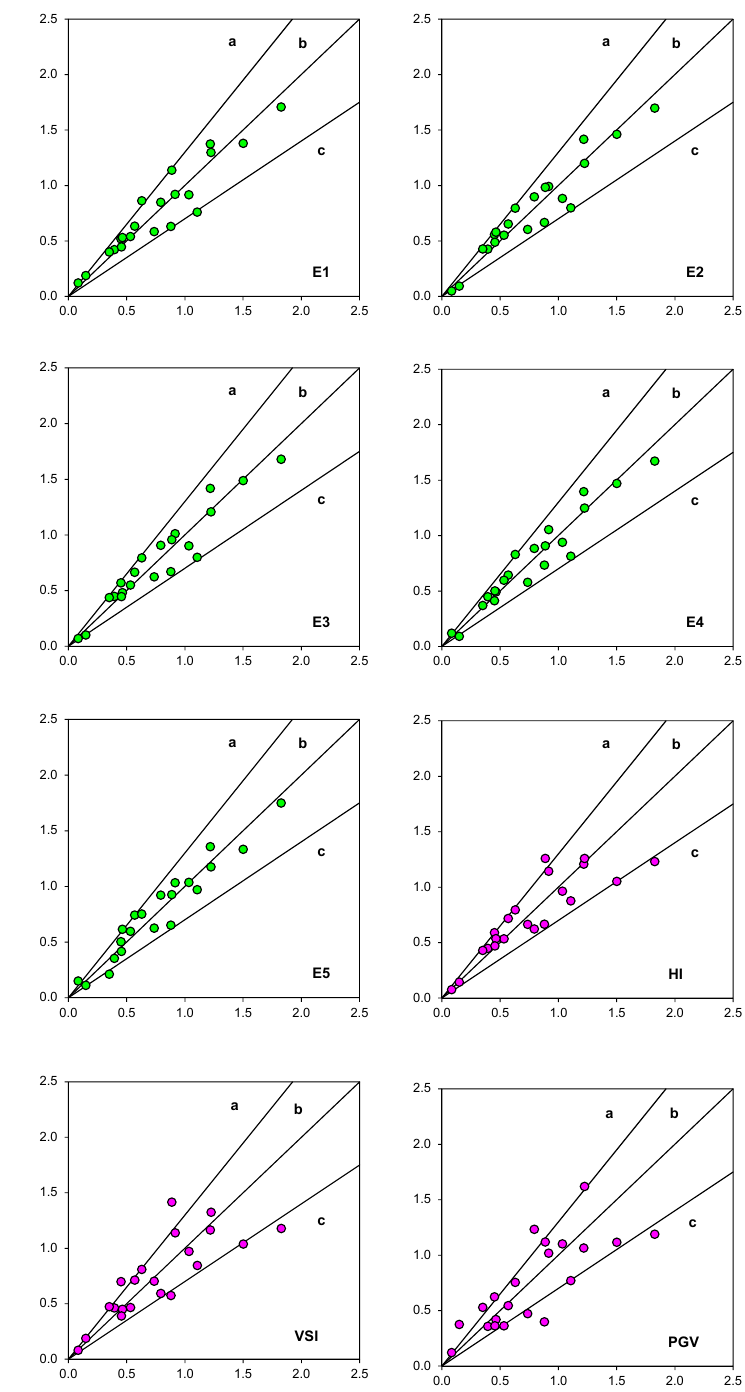
RDR values obtained for common parameters (HI, PGV, and VSI) and E 1 − E 5 are plotted in Figure 12. The different estimated to analysis roof drift ratios are also drawn on the figure as lines a, b, and c (RDR estimated /RDR analysis = 1.3, 1 and 0.7) to show the scatter more clearly. Figure 12 shows that all estimated values of the E 1 –E 5 are within a and c lines, while the other parameters, especially the PGV, have a considerable number of estimates out of these lines.